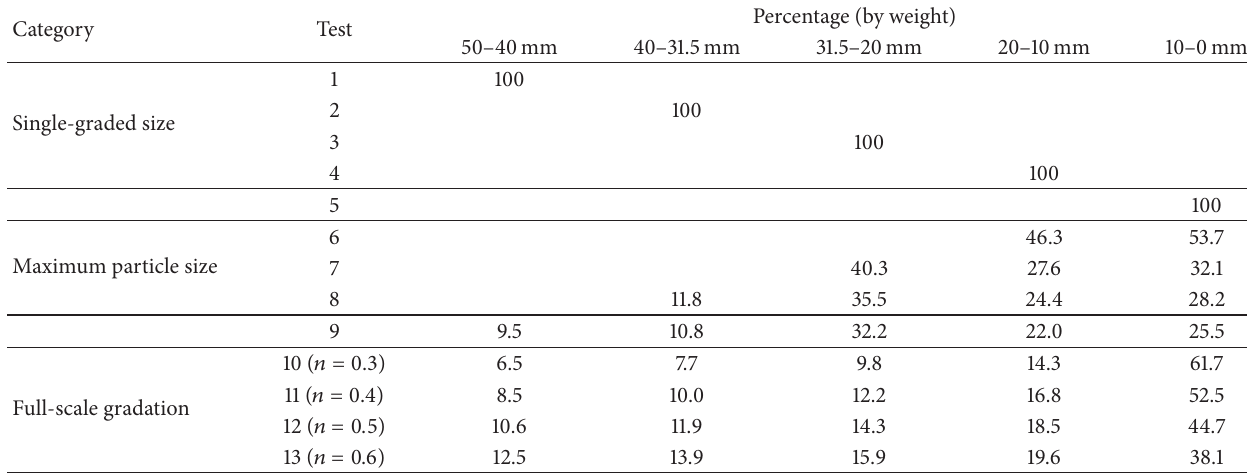
Figure 3: Plan and elevation views of compression device. Table 1: Load deformation test series with different